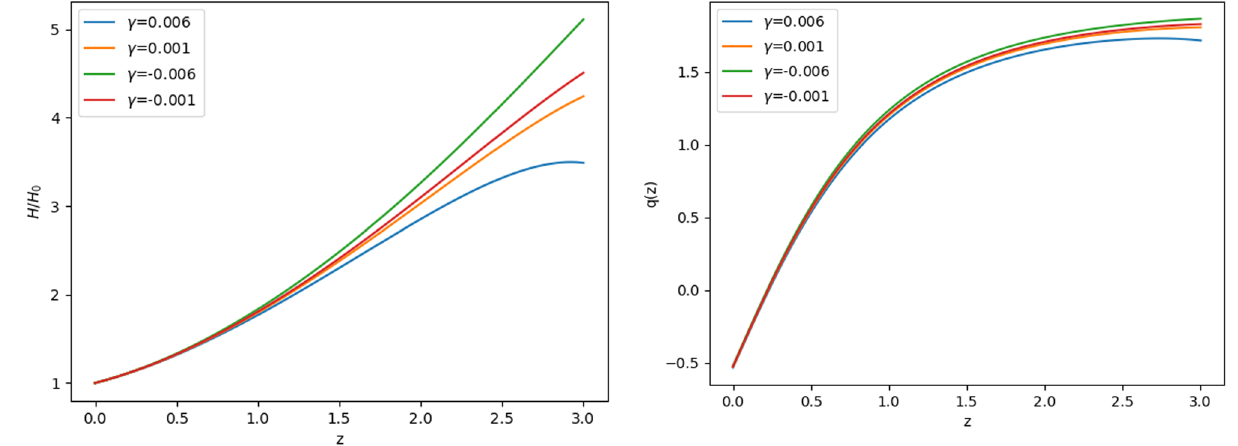
Figure 2: The variation h in redshift, as normalised by the value of H 0 today.